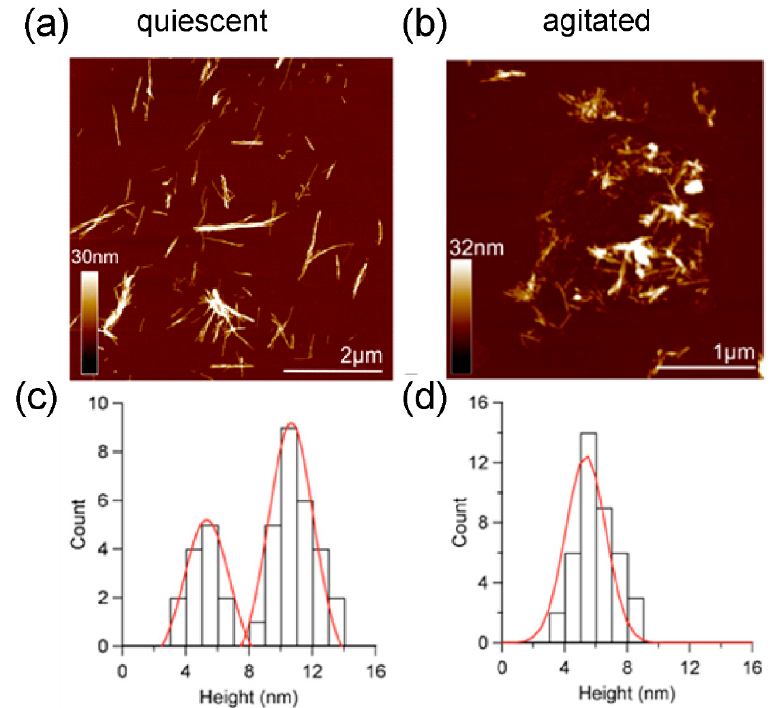
Figure 3. Atomic Force Microscopy Analysis. Fibrils formed under ( a ) quiescent and ( b ) agitated conditions. Height distribution analysis shows ( c ) two height populations of 5.1 ± 1.0 ( n = 170) and 10.7 ± 1.4 nm ( n = 90) for quiescent fibrils, ( d ) with only one species of average height 5.3 ± 1.1 nm for agitated fibrils.